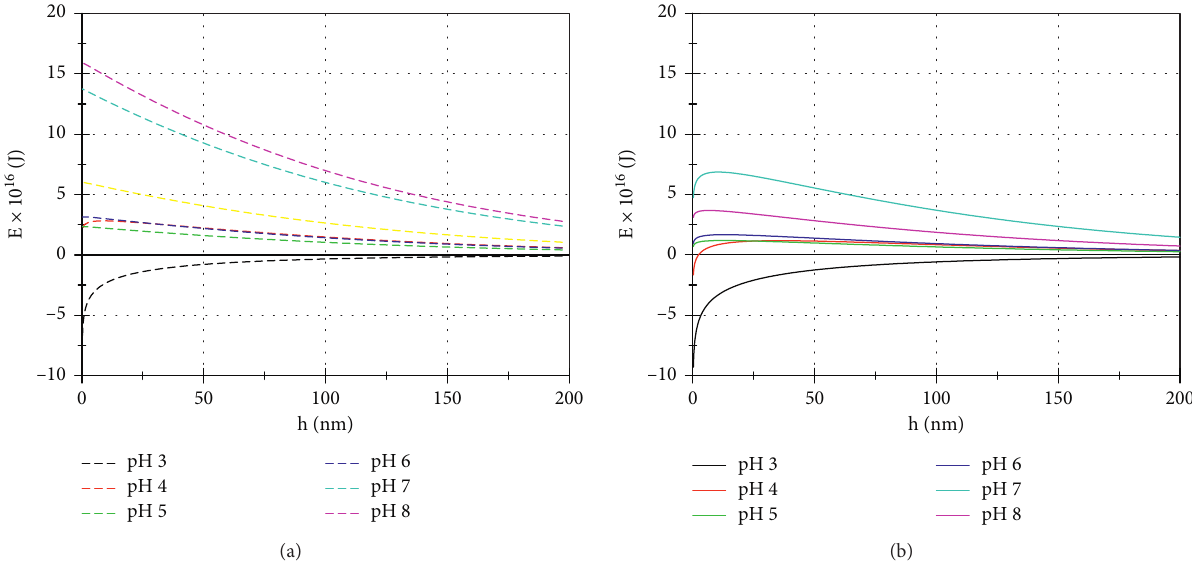
Figure 6: DLVO interaction energy between (a) Coal 1 particle and an air bubble and (b) Coal 2 particle and an air bubble at different pH values.